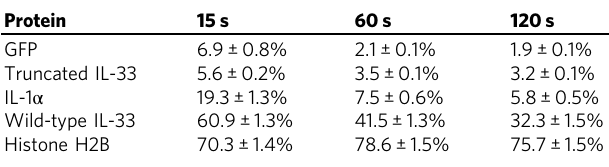
Mean and standard error of the mean of the percentage of intracellular fl uorescence intensity at the indicated timepoints from Fig. 6 relative to time zero GFP green fl uorescent protein, IL interleukin, s